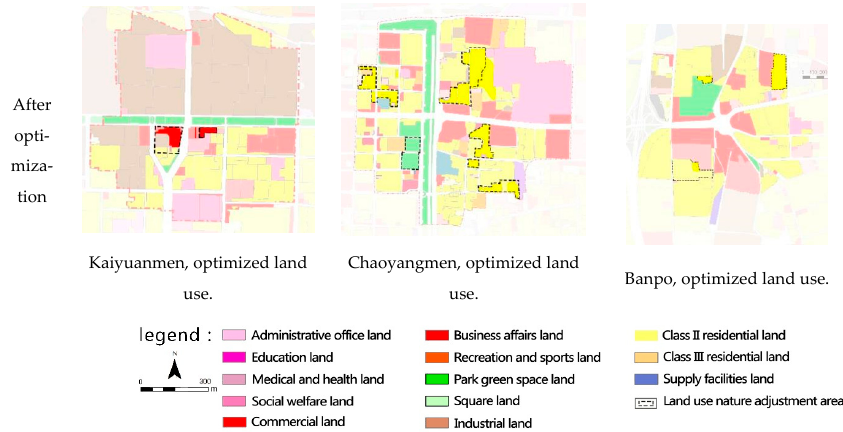
Figure 7. Optimization map of the land use for each station.